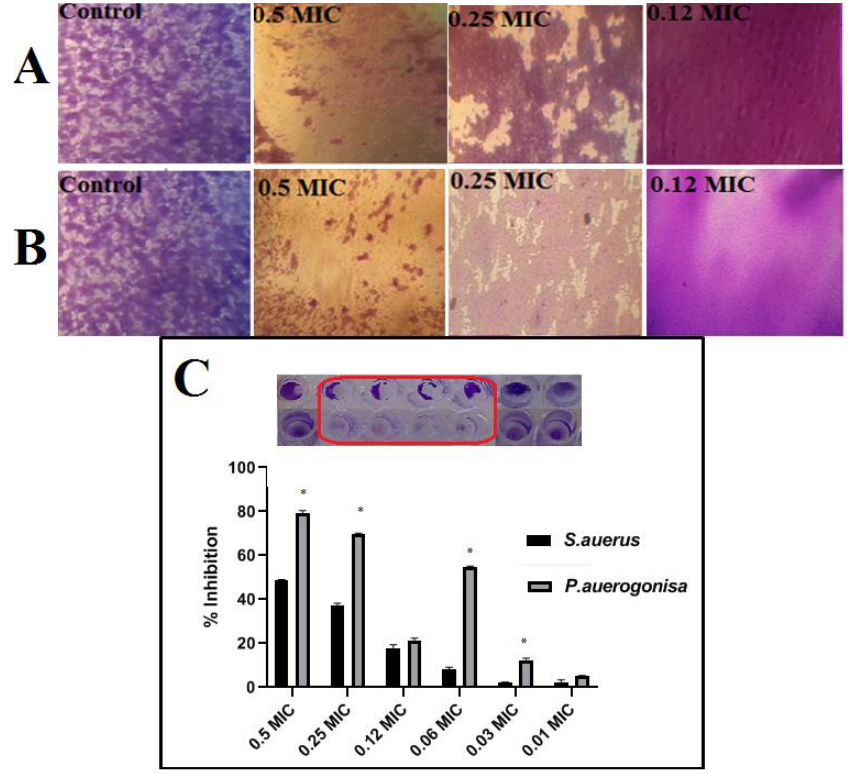
Figure 5. Light-inverted microscopic images of S. aureus ( A ) and P. aeruginosa ( B ) biofilms grown